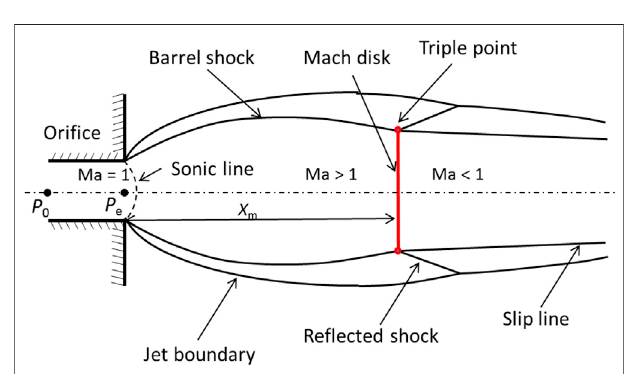
FIGURE 2 | The schematic of the under-expanded